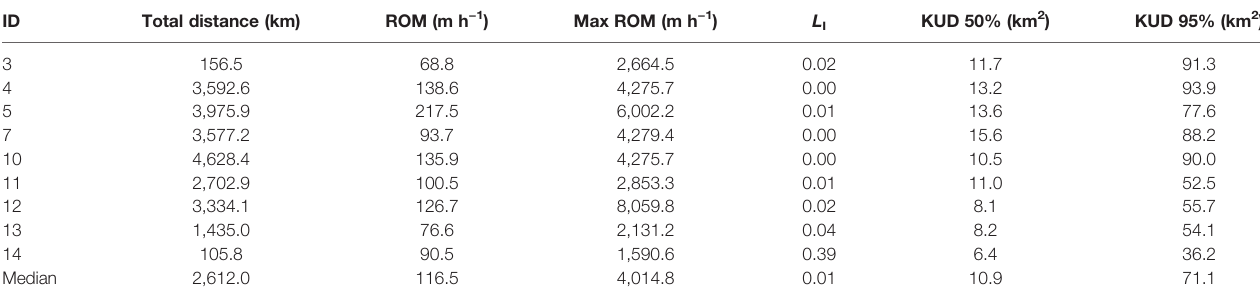
TABLE 2 | Habitat use and movement statistics estimated for nine acoustically tagged smooth hammerhead shark Sphyrna zygaena (ID), including total distance travelled (km), mean (ROM) and maximum (Max ROM) rates of movement (m h − 1 ), linearity index (L I ), core activity (KUD 50%, km 2 ), and home range (KUD 95%, km 2 ) areas. ID Total distance